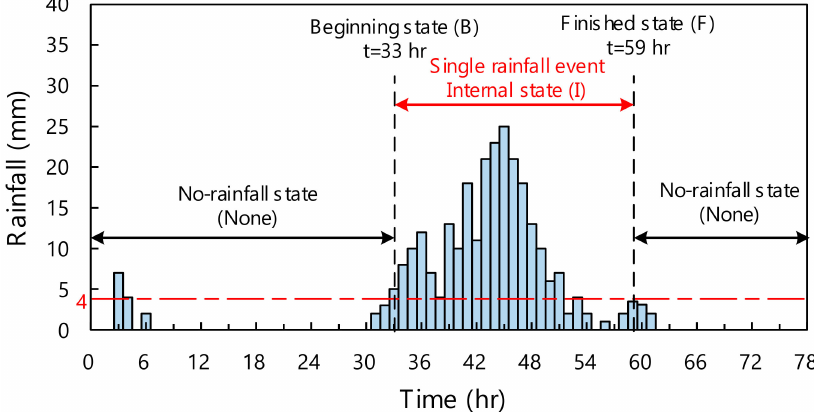
Figure 2. Schematic diagram of the rainfall-event definition used in the